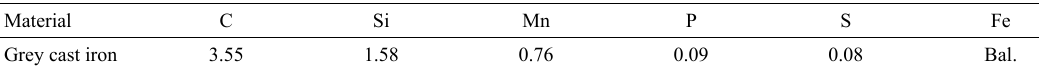
Table 1. Chemical composition for as-received grey cast iron. Material